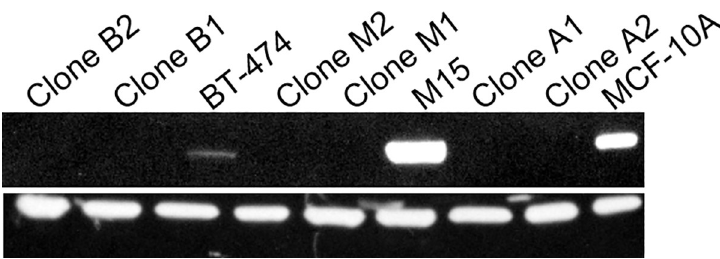
Fig 1. Western blot analysis showing loss of STAT6 protein expression in STAT6 -/- clones. MCF-10A-derived clones A1 & A2, M15-derived clones M1 & M2, and BT474-derived clones B1 & B2.